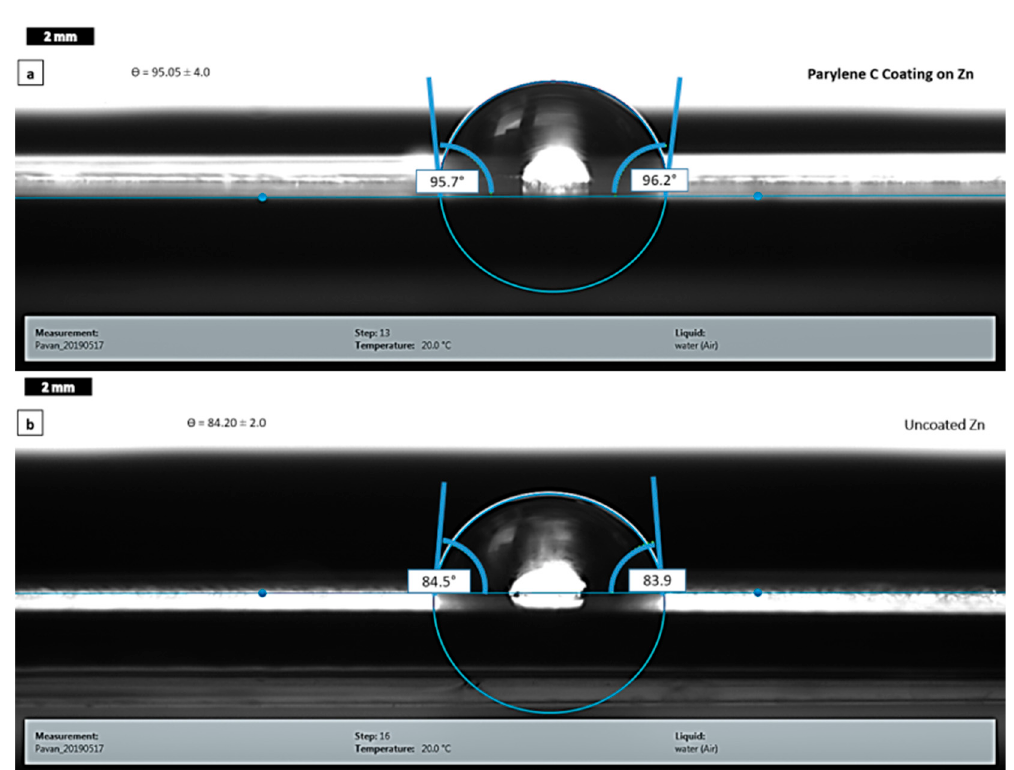
Figure 13. Photographs of water droplets and the measured contact angles Θ on the surface of: ( a ) Parylene C-coated Zn; ( b ) Uncoated Zn.